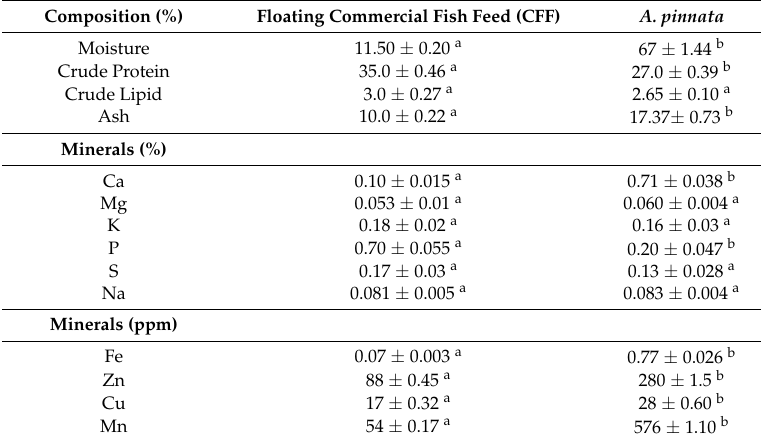
Table 1. Proximate composition (% in dry weight) and minerals content of the floating commercial fish feed and fresh Azolla pinnata